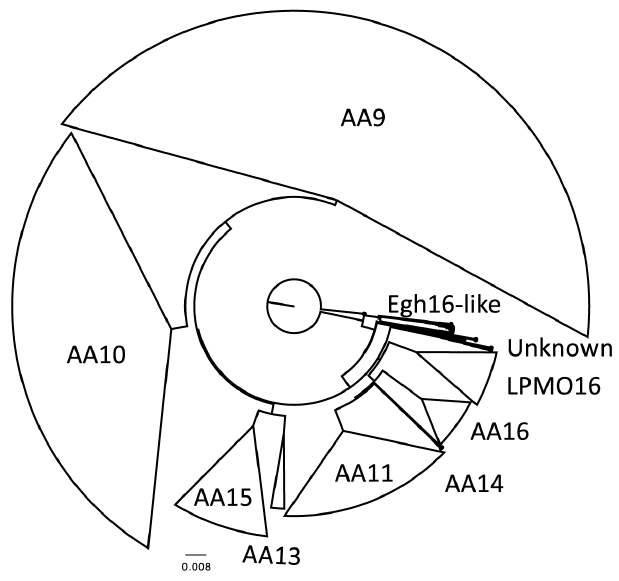
Figure 6. Simplified LPMO phylogenetic tree and relative abundance of LPMO families. The initial non-redundant dataset was clustered at 70% sequence homology and each cluster resulted in a single alignment. PHMMs were build and a UPGMA tree was constructed using PRCx. The phylogenetic tree was subsequently rooted using the Egh16-like family as an